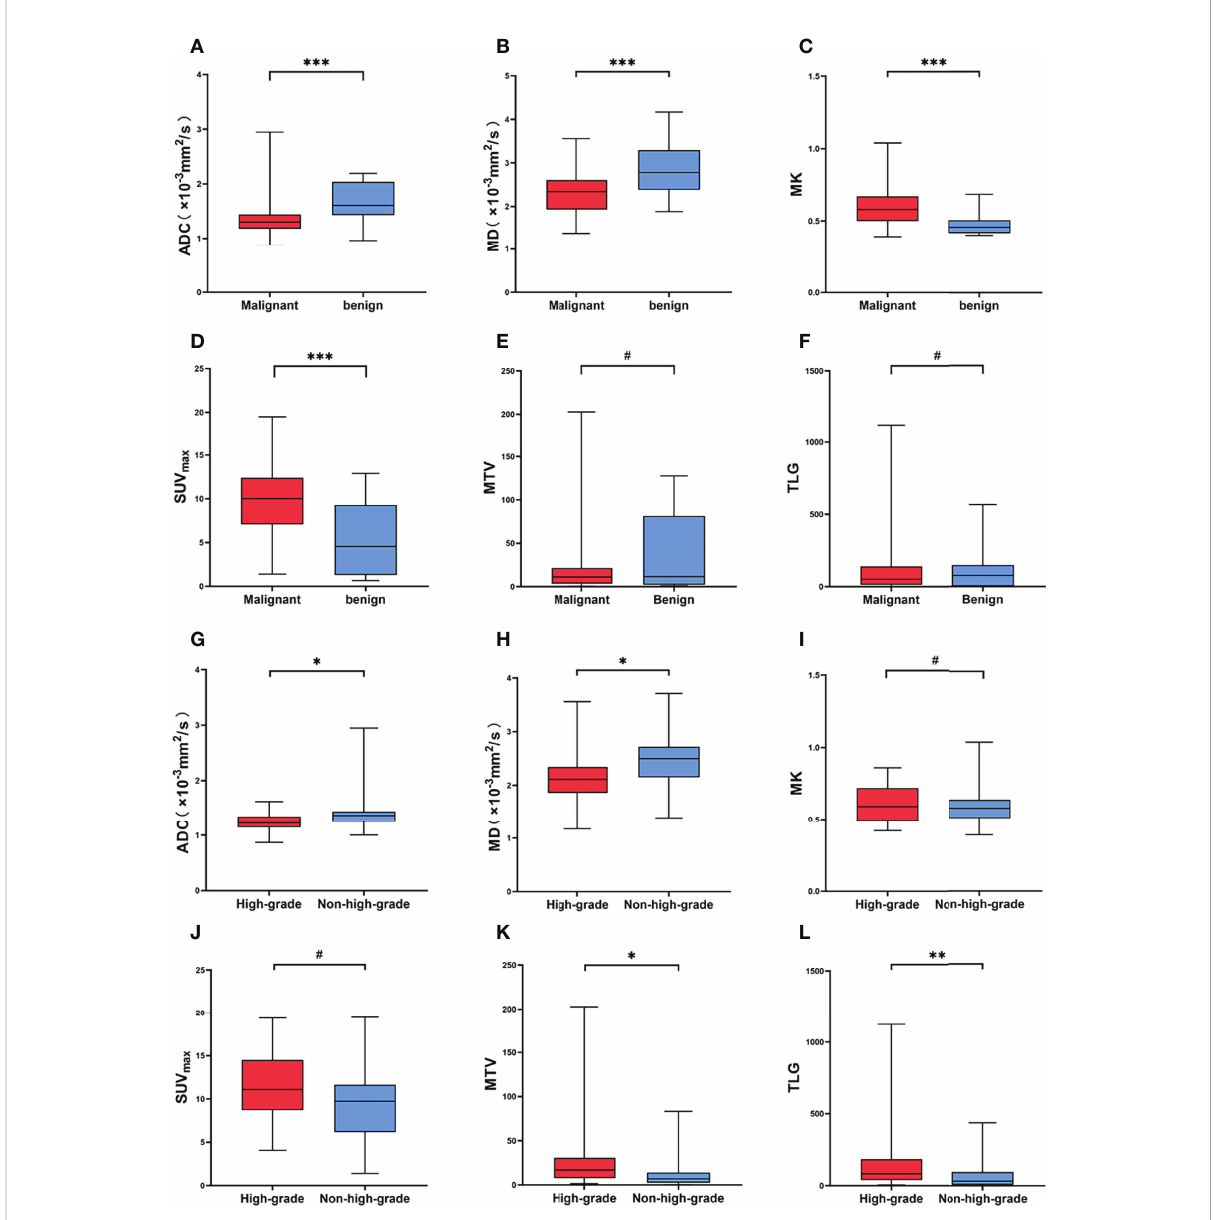
FIGURE 3 (A – F) Comparison of different parameters between malignant and benign SPL groups. (G – L) Comparison of different parameters between high-grade and non-high-grade in malignant SPL group. # Represents P > 0.05, * represents P < 0.05, ** represents P < 0.01, *** represents P <